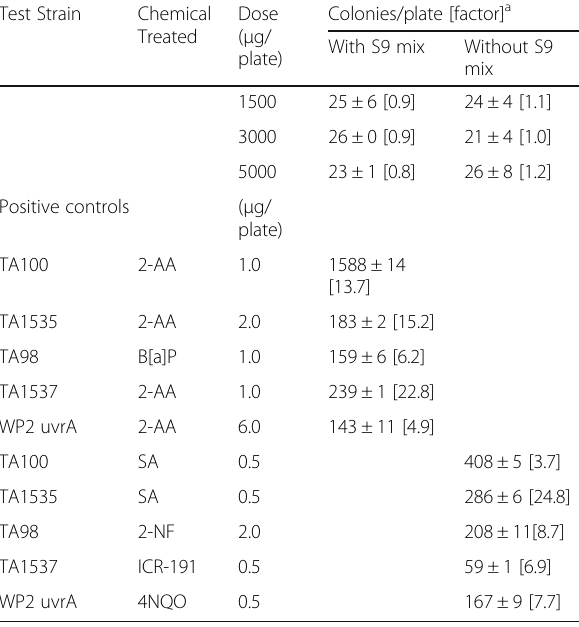
Table 5 Bacterial reverse mutation